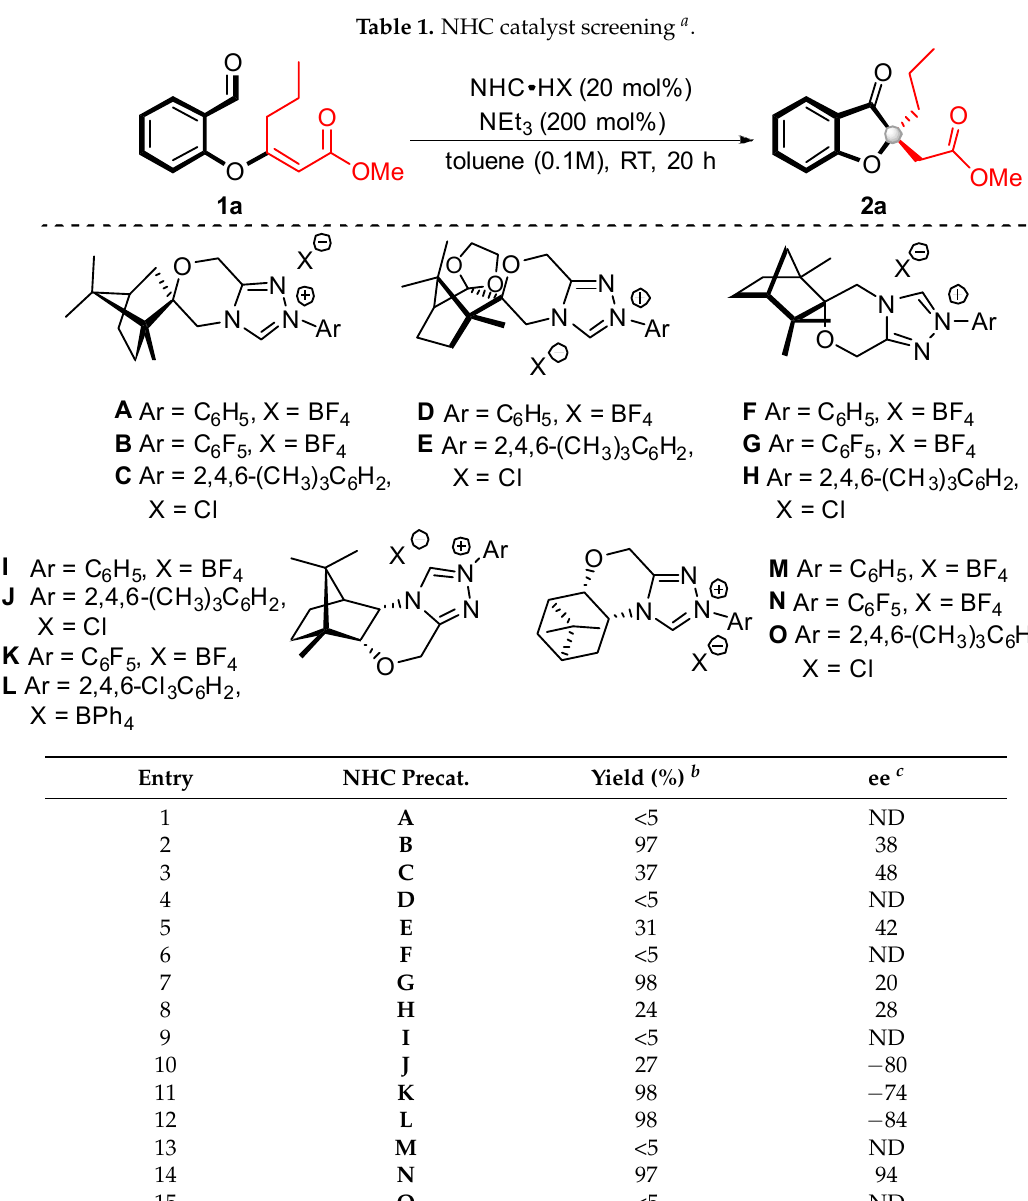
Table 1. NHC catalyst screening a .